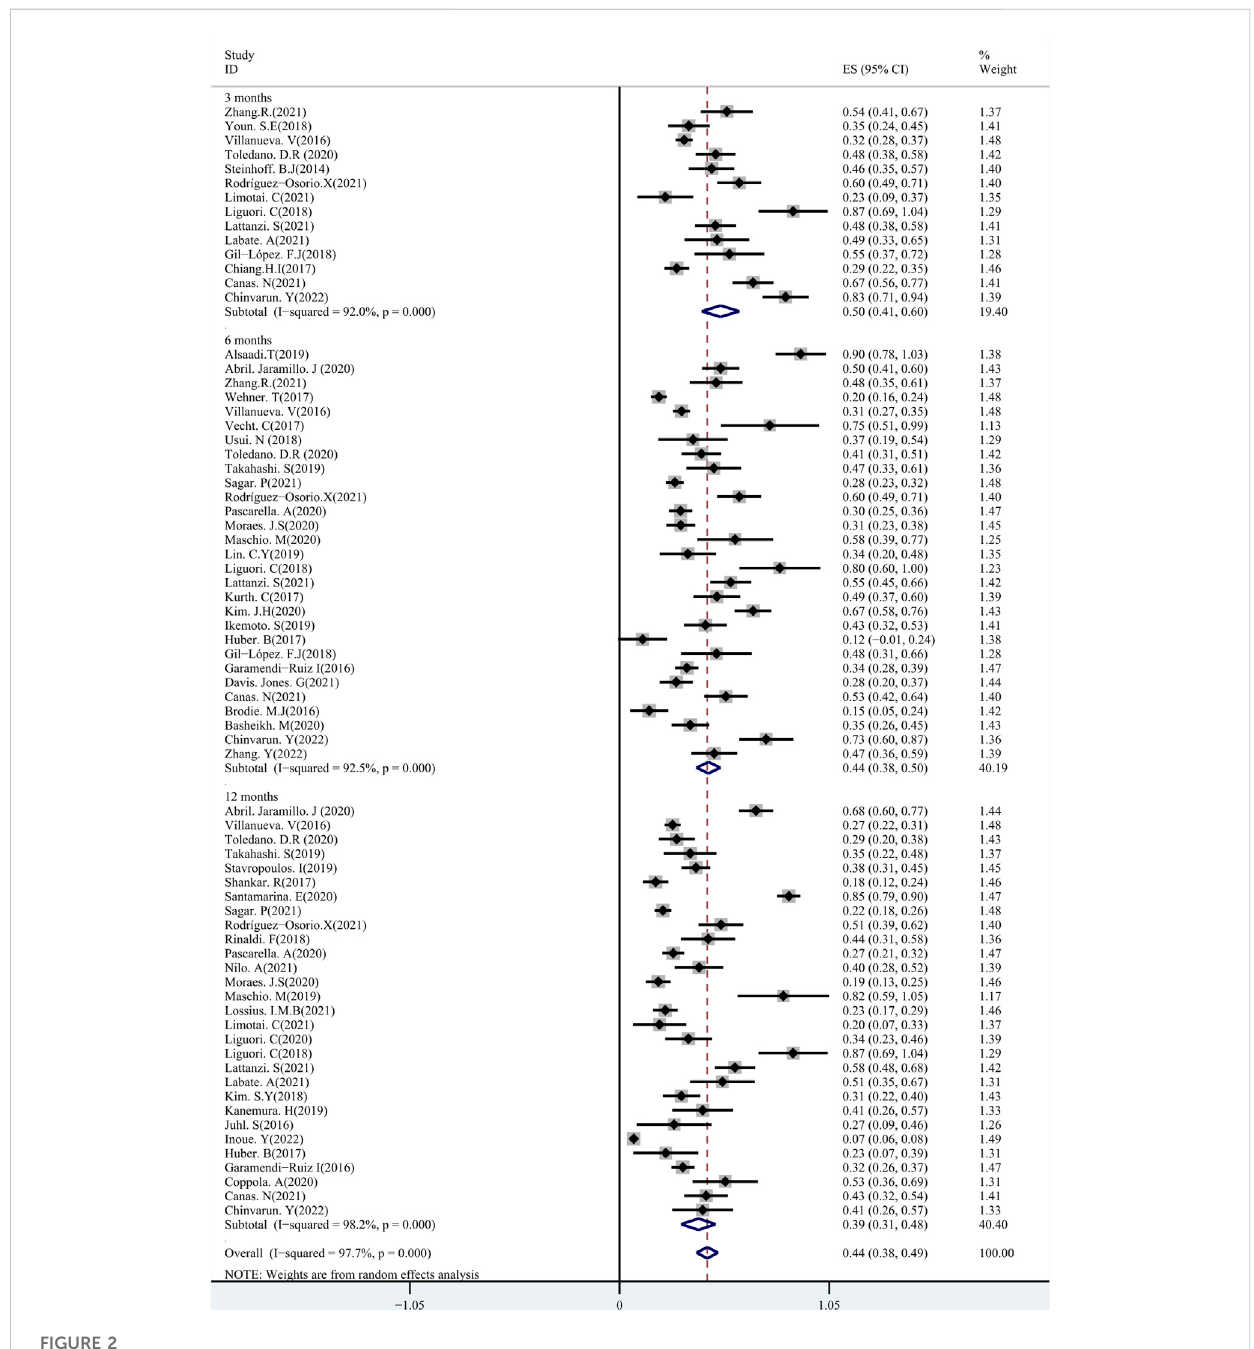
FIGURE 2 Meta-analysis of 50% responder rate: pooled data from 48